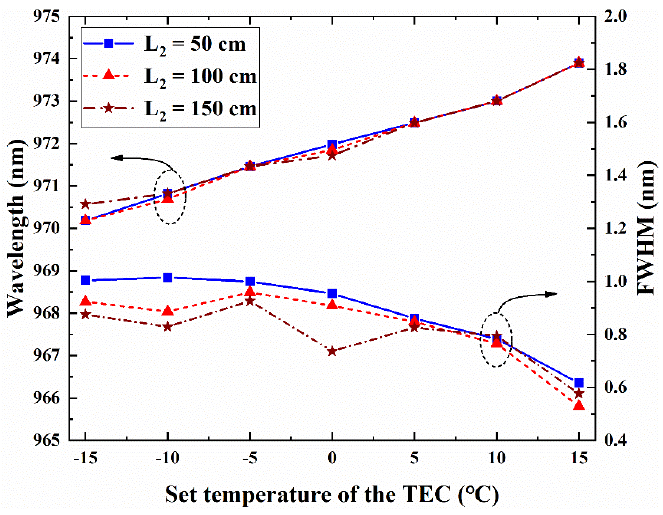
Figure 8. Output wavelength and FWHM of VECSEL varying with the temperature at different transmission distances.